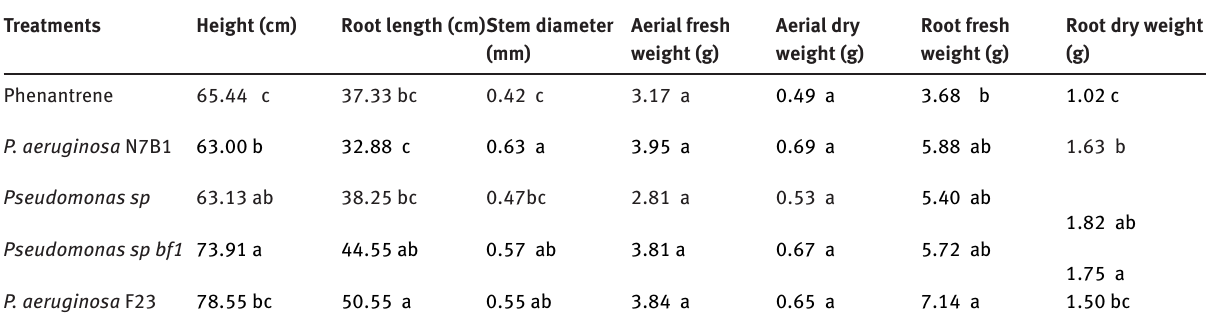
Table 2 : Pseudomonas strains inoculation and aromatic hydrocarbons (with phenanthrene 500 ppm) effect, on maize growth